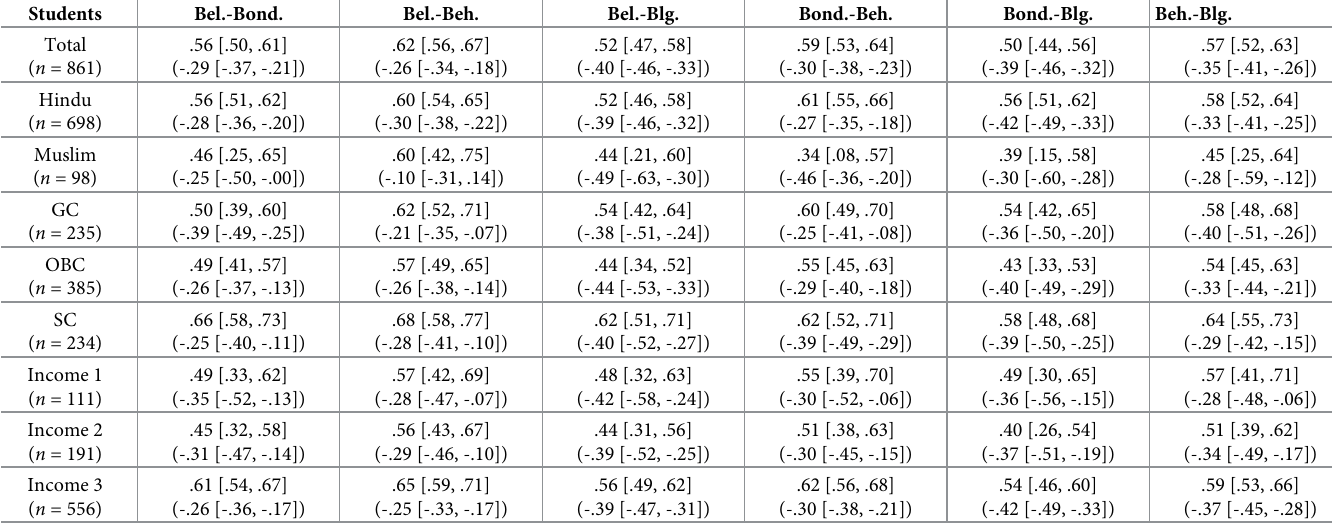
Table 8. Simple and partial (in parenthesis; after controlling religiousness) correlations between the dimensions of religiousness in social, economic, and religion groups among the students’ sample. Students Bel.-Bond. Bel.-Beh.